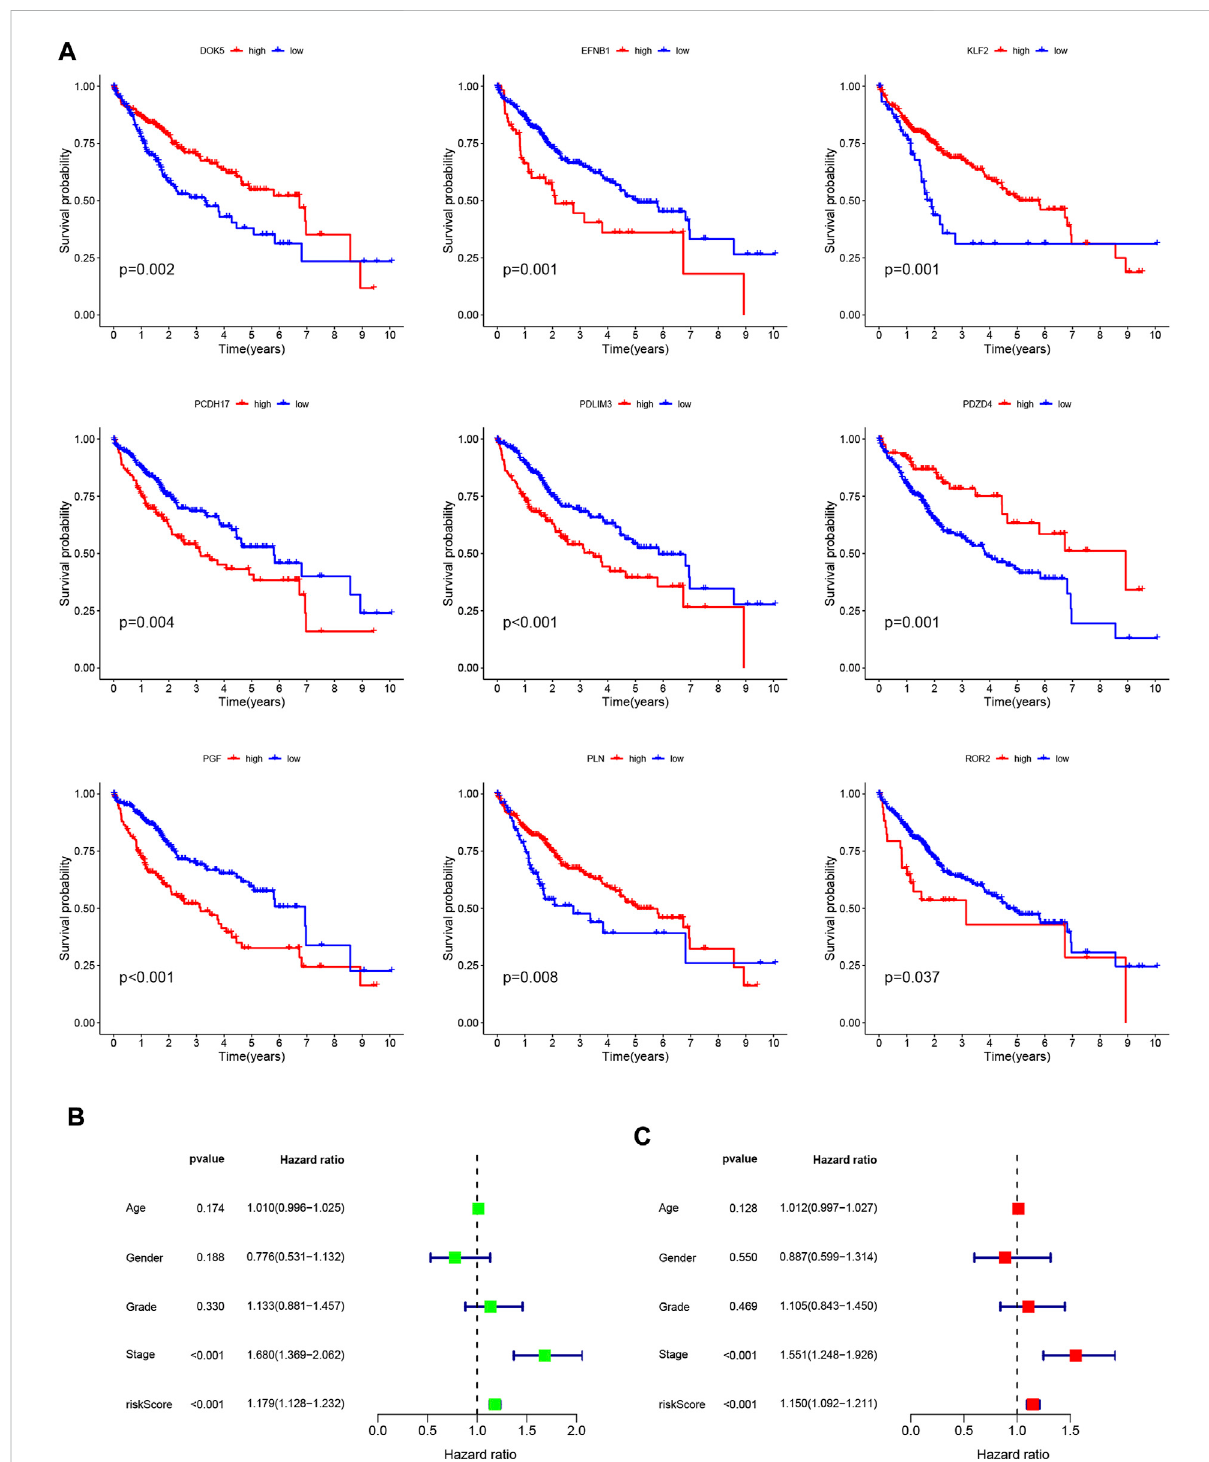
FIGURE 4 (A) Kaplan-Meier curve analysis showed the difference in overall survival between the high and low expression groups for 9 neutrophil-related genes( PDLIM3 , KLF2 , ROR2 , PGF , EFNB1 , PDZD4 , PLN , PCDH17 , DOK5 ). (B) UnivariateCox regression results for overall survival. (C) Multivariate Cox regression results for overall